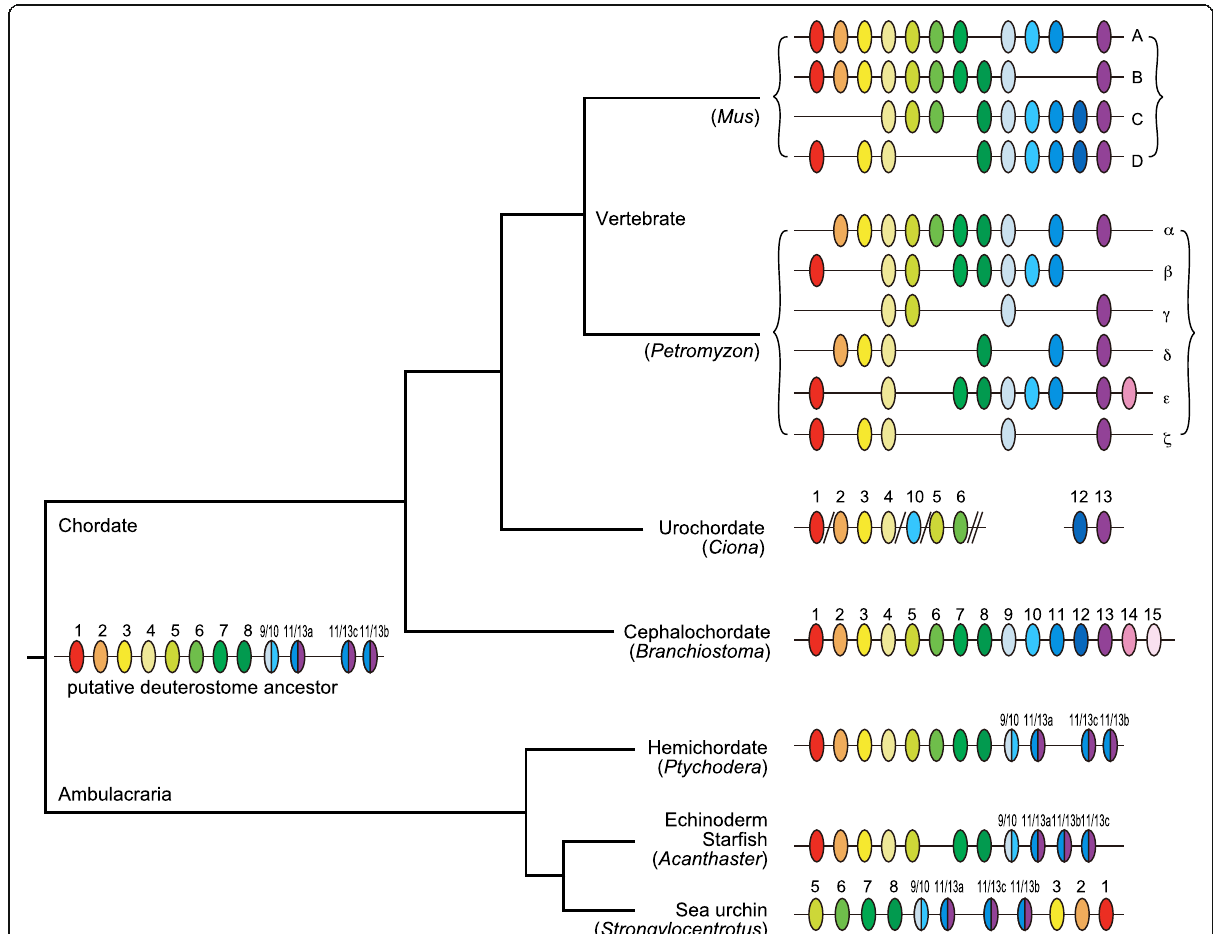
Fig. 3 Hox-cluster gene organization in deuterostomes. Colored ovals indicate Hox genes. Genes of smaller paralogous subgroup numbers are to the left and those of larger numbers are to the right. A putative chordate ancestor may have possessed a single Hox gene cluster with ~ 13 genes. This would have been conserved in hemichordates and cephalochordates, although cephalochordates must have undergone duplication of the posterior-most genes. Echinoderms most likely lost Hox6 . In urochordates, the Hox cluster was reorganized; in Ciona intestinalis , Hox genes are mapped on two chromosomes and the putative gene order is shown for Hox2 to 4 and Hox5 and 6. Jawed vertebrates, except teleosts, have four Hox gene clusters (HoxA to HoxD from top to bottom), whereas the sea lamprey contains six Hox gene clusters (Hox- α to Hox- ζ ). ( References are in the text